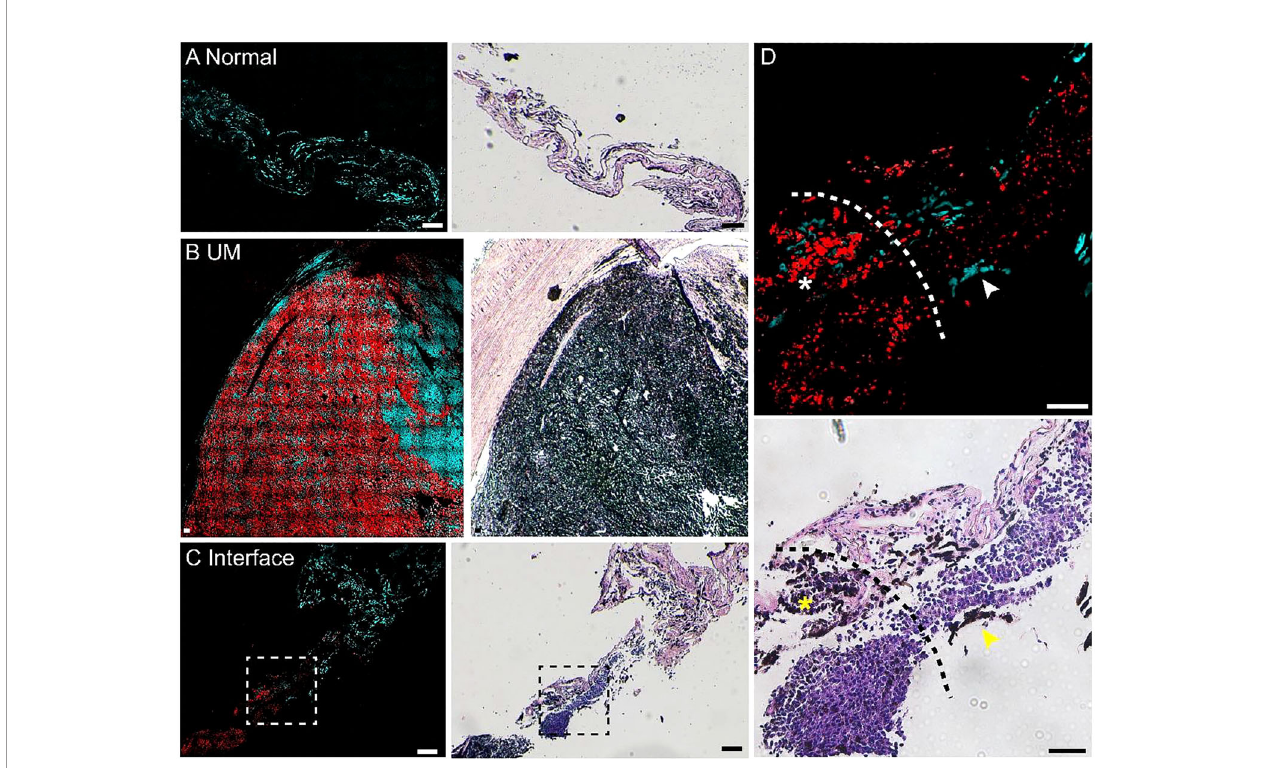
FIGURE 3 | Pump-probe imaging of paraf fi n-embedded sections. (A) A normal choroid tissue section. (B) A melanoma tissue section excised from a uveal melanoma (UM) patient. (C) A tissue section from the interface area with clear eumelanin/pheomelanin contrast. (D) Magni fi ed view of the interface (dashed square in panel C ), eumelanin (asterisk) and pheomelanin (arrowhead) are hardly resolvable in H&E. Red: eumelanin; cyan: pheomelanin. Scale bar: 50 m